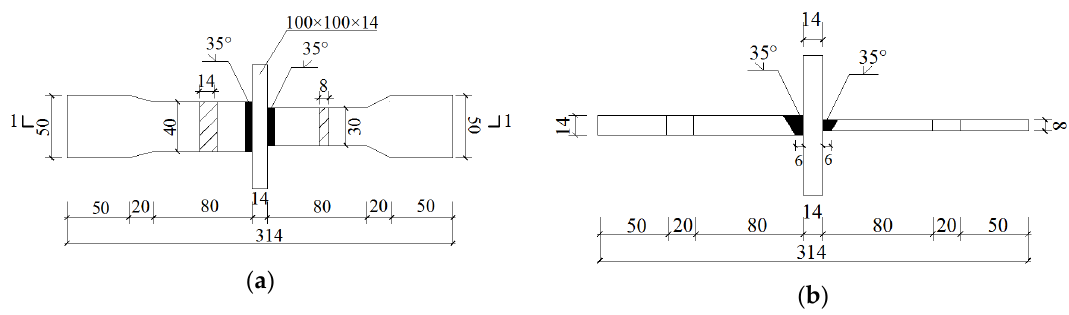
Figure 2. Configuration and dimensions of welded plate joint (mm): ( a ) top view; ( b ) side profile.